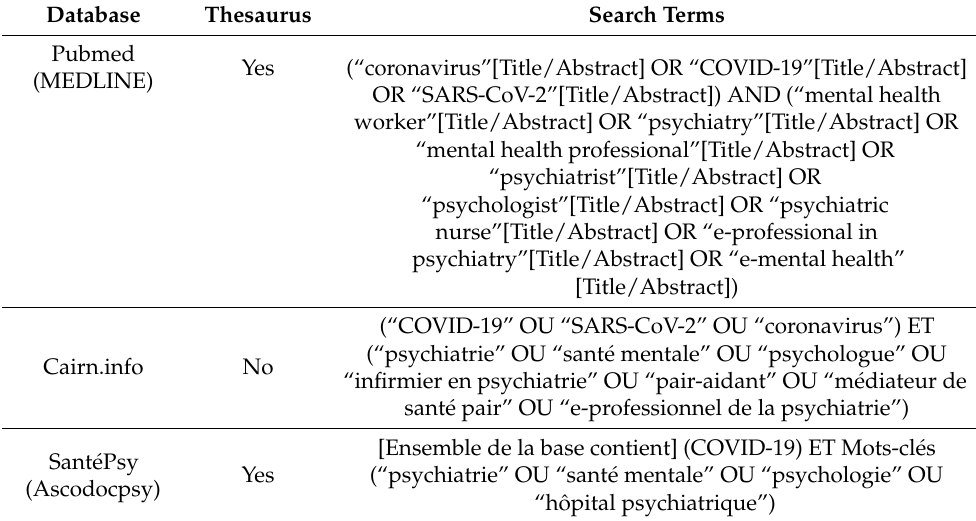
Table 1. Search method of the literature